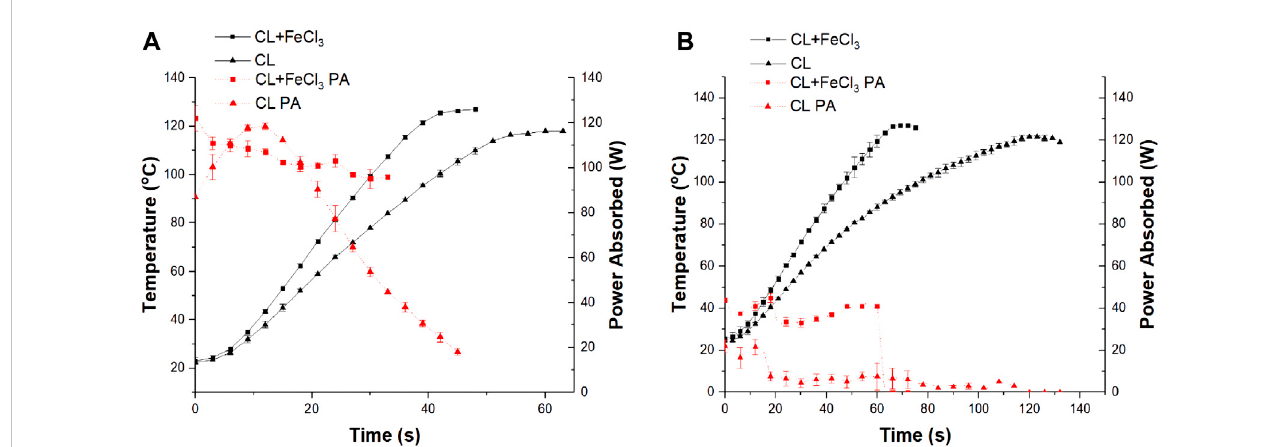
FIGURE 1 Example of typical temperature pro fi le (black solid line) and power pro fi le (red dot line) of CL and CL + FeCl 3 mixture (n = 5) using (A) EH and (B) HH heating methods at 150 W input power. PA, power absorbed.